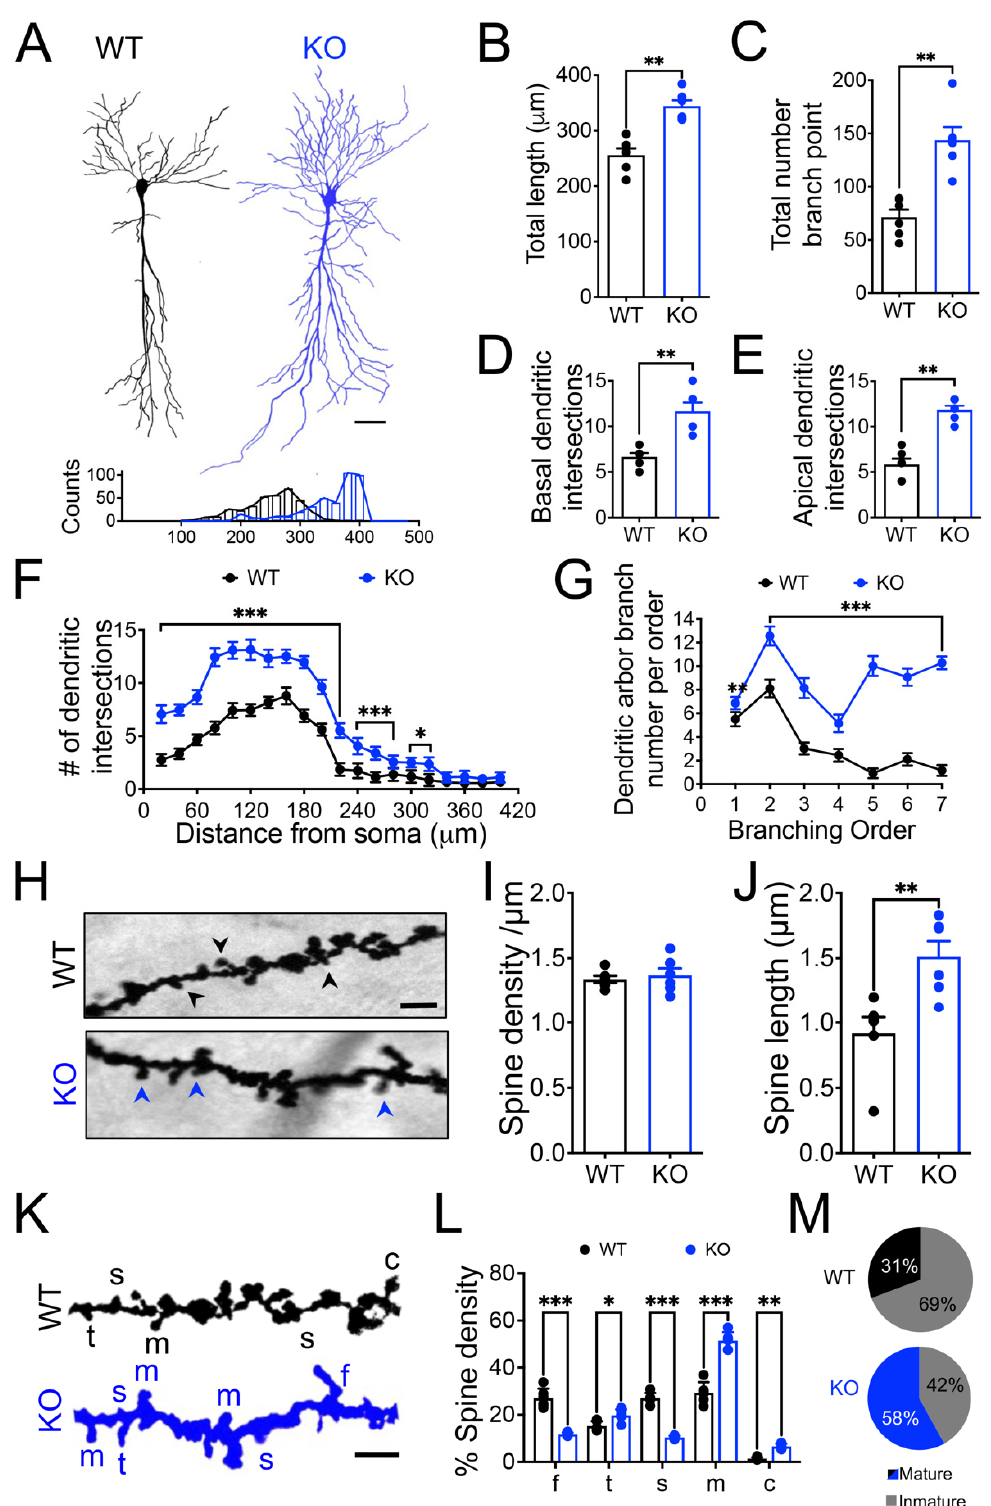
Figure 4. Enhanced dendritic arborization and spine maturation in Panx1-KO neurons. ( A ) Representative drawings of the Golgi-stained CA1 neurons ( top ) and histogram distribution of total dendritic length ( bottom ) for WT (black) and Panx1-KO (KO, blue) mice. Magnification, 40X; bar: 40 µ m. ( B ) Averaged total dendritic length. n = 100 (WT) and n = 100 (KO) neurons from 6 animals, ** p = 0.002 Mann–Whitney test. ( C ) Averaged basal dendritic branches. n = 100 (WT) and n = 100 (KO) neurons from 6 animals, ** p = 0.002 Mann–Whitney test. ( D ) Averaged apical dendritic